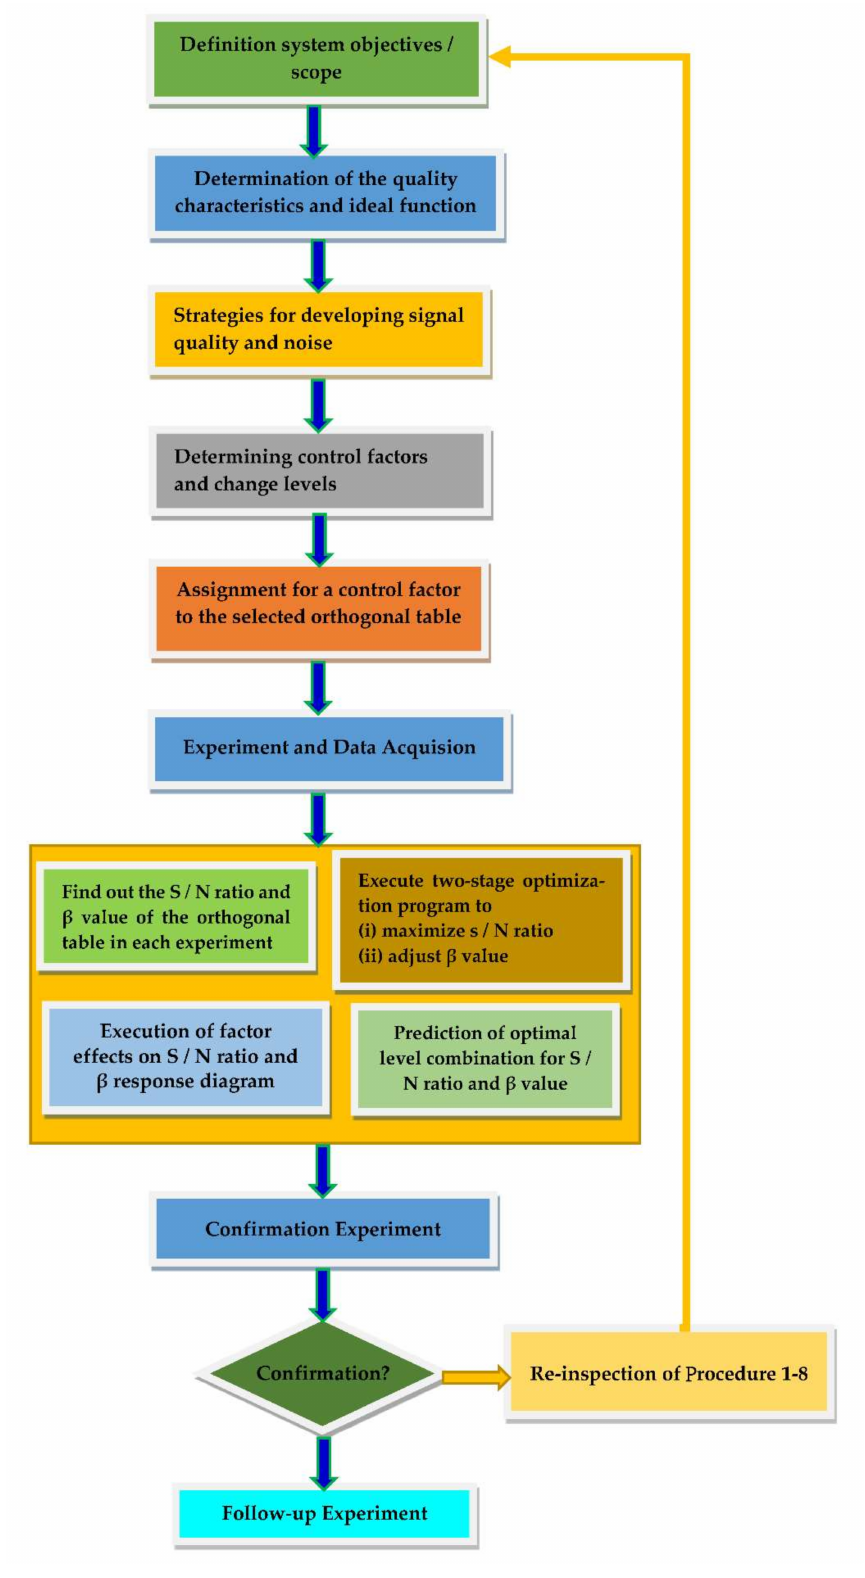
Figure 6. Robust parameter design of a fuel injection system. Step 1: Select the control parameters. In the experiment, two injection MPCI modes are adopted. The first injection time and the second injection time are used as the control